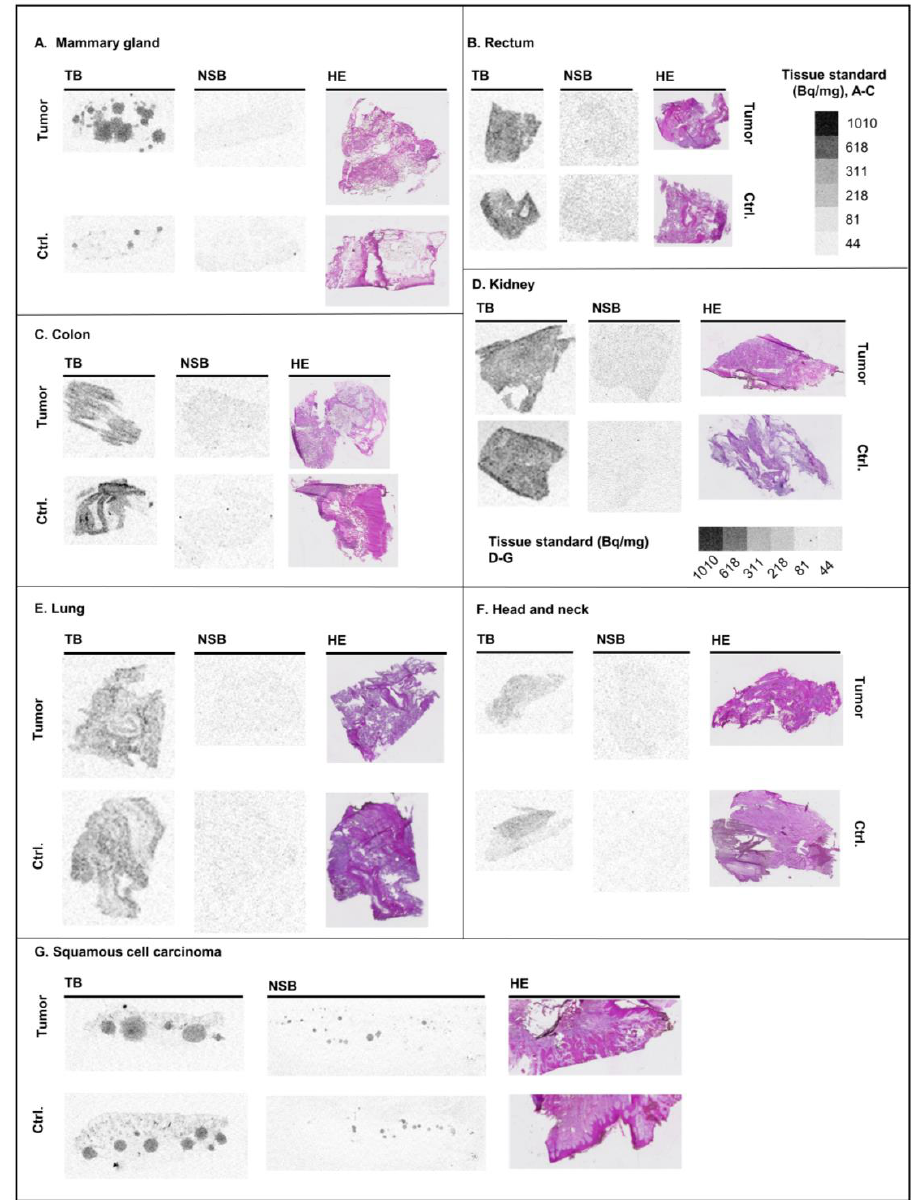
Figure 6. Representative images of cancer sections and healthy adjacent tissue obtained from the same individual. ( A ) mammary gland, ( B ), rectum, ( C ) colon, ( D ) kidney ( E ) lung, ( F ) head and neck, ( G ) squamous cell carcinoma. TB, total radioligand binding; NSB, non-specific binding (determined in the presence of 5 µ M FR), HE, hematoxylin-eosin staining. For autoradiography, organ slices were incubated with 10 nM [ 3 H]PSB-15900-FR for 1 h at room temperature. Tissue equivalent standards are displayed at the bottom